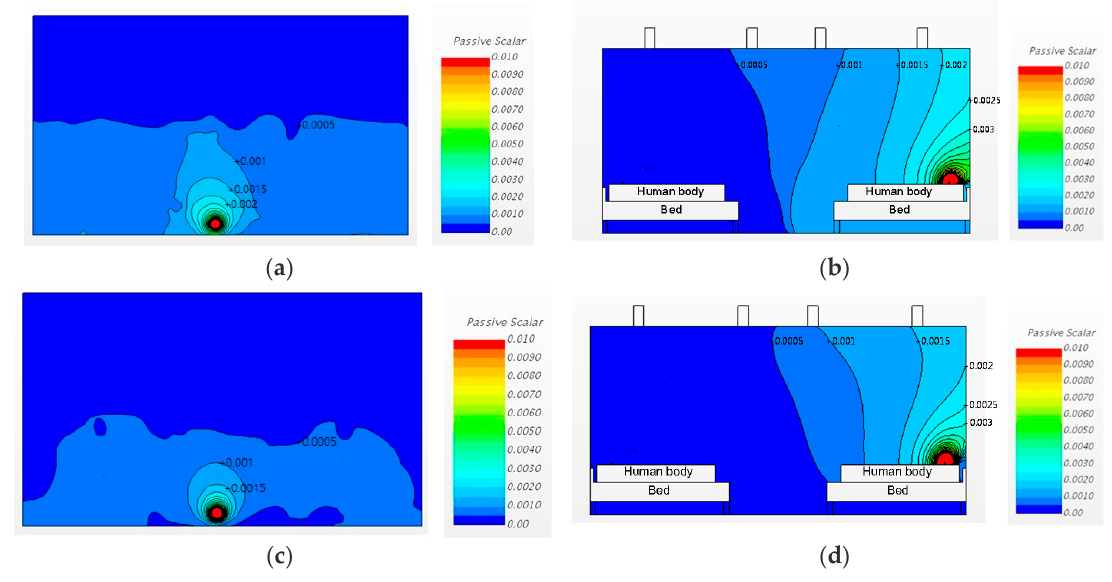
Figure 9. Airflow patterns and pathogen concentrations for Cases 3 and 4: ( a ) Case 3, plan view (h = 1.0 m); ( b ) Case 3, sectional view; ( c ) Case 4, plan view (h = 1.0 m); ( d ) Case 4, sectional view.